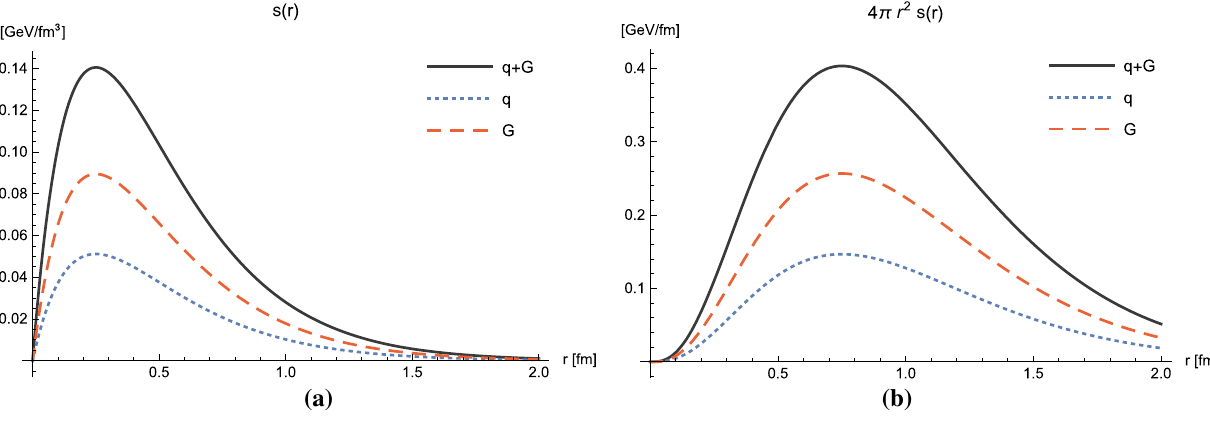
Fig. 7 Plots of the pressure anisotropy, a s ( r ) and b 4 π r 2 s ( r ) , using the multipole model (11) with parameters given in Table 1, see Eq. (38) or Eq. (43) for definitions in terms of